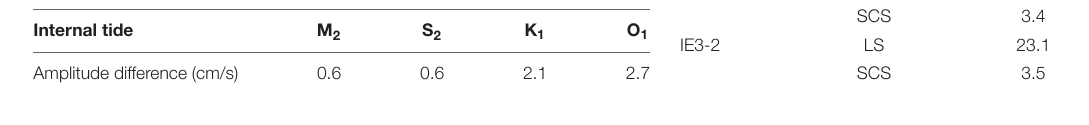
TABLE 1 | Differences (vertical mean absolute errors) in M 2 , S 2 , K 1 , and O 1 eastward tidal current amplitudes between observations and simulated results.